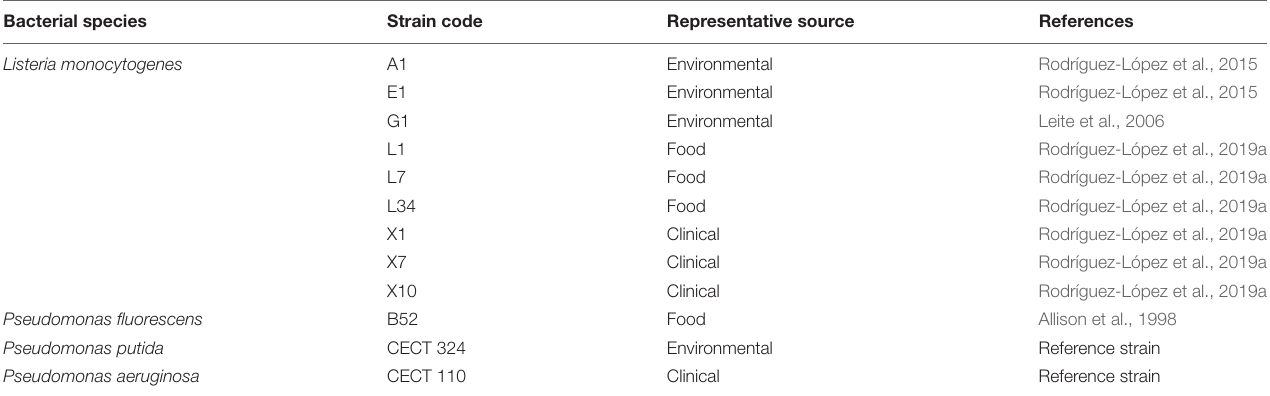
TABLE 1 | List of bacterial strains and codes used in this